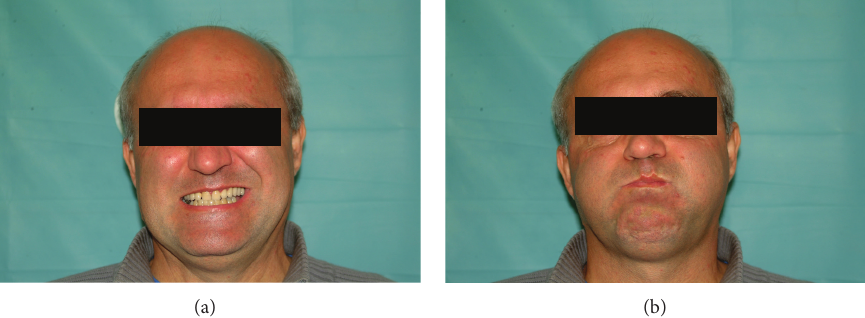
Figure 4: Forty-two days following stapes surgery, the facial nerve function is intact: teeth showing (a) and lip rounding